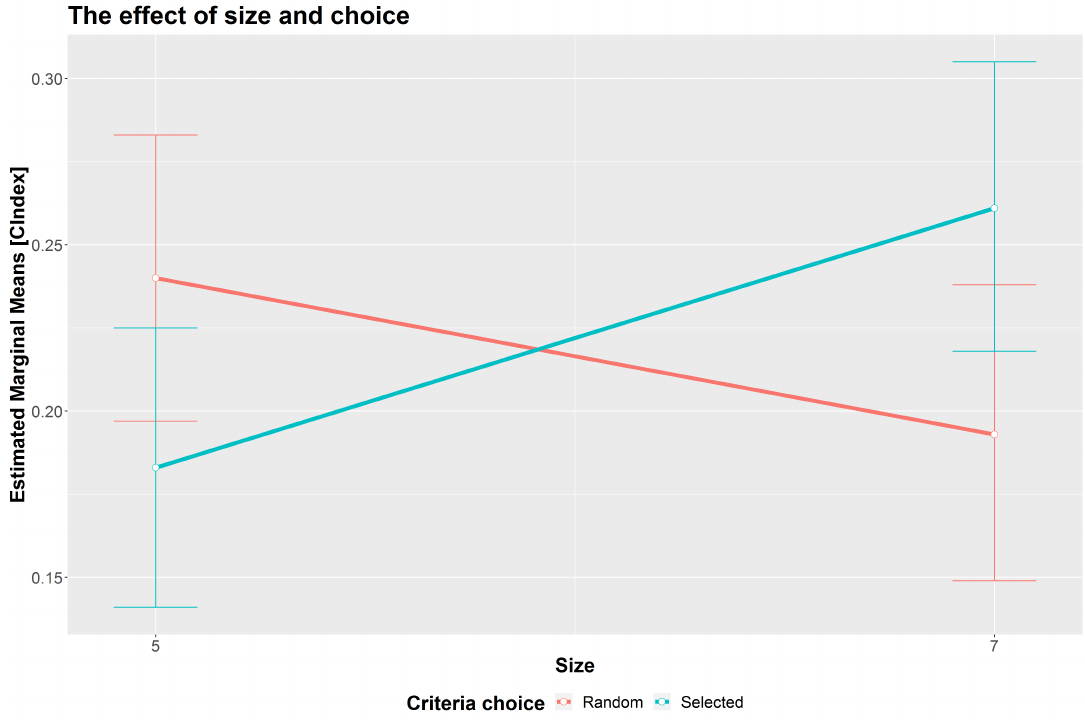
Figure 2. Estimated marginal means of inconsistency as measured by the CIndex coefficient across sizes and choice of criteria. The error bars represent 95% confidence intervals.